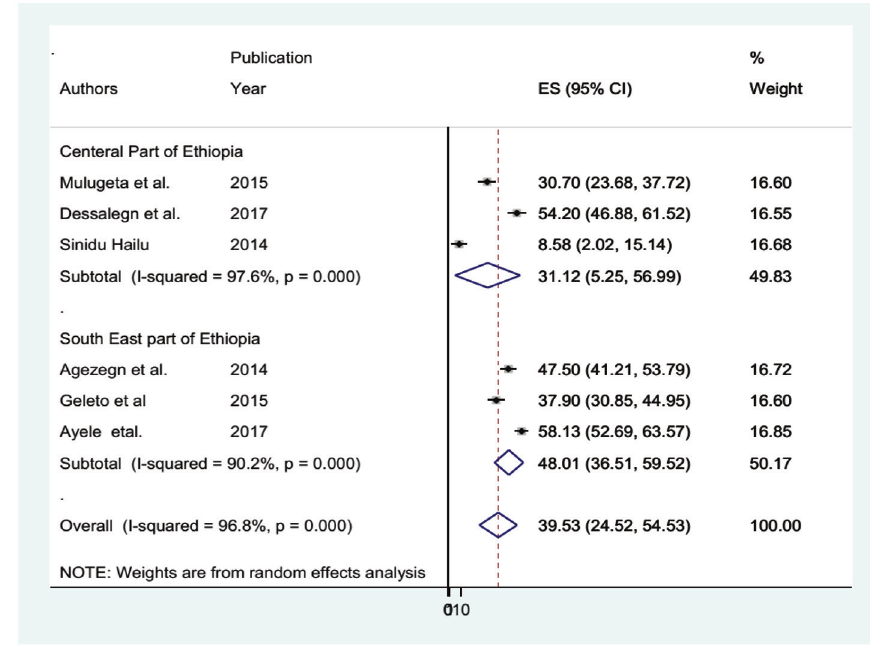
Figure 2. Forest plot of the six studies that quantitatively assessed prevalence of nurses’ job satisfaction in Ethiopia,